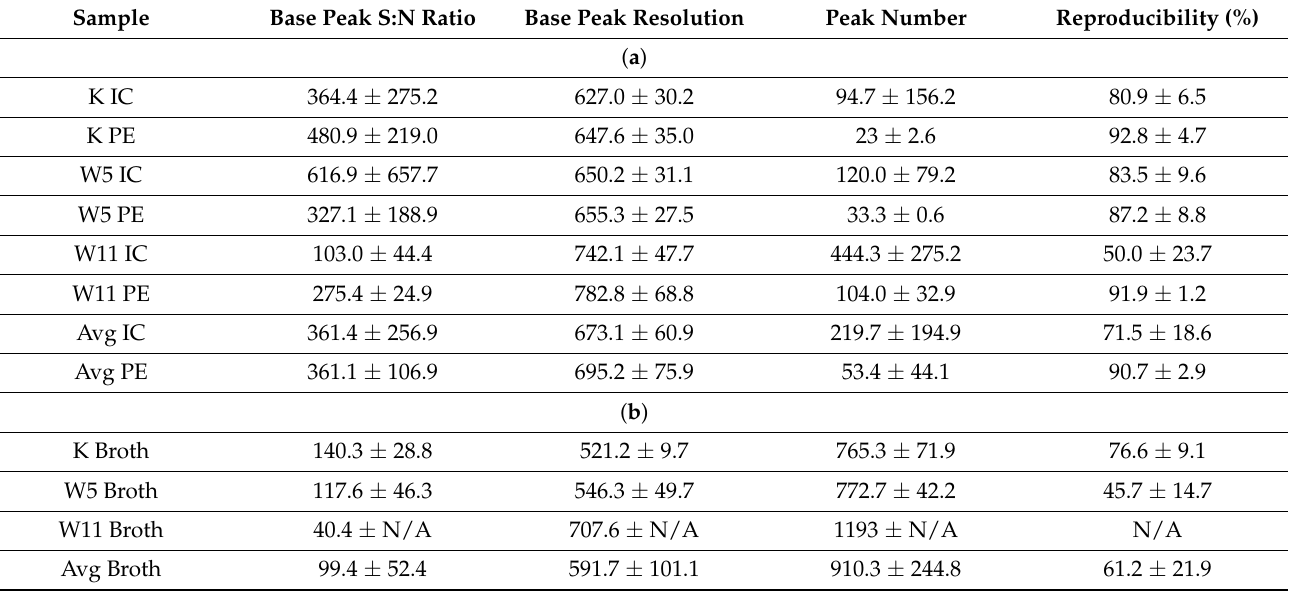
a Data shown represent averages of triplicate samples from a single preparation followed by their standard deviations. Results for all parameters show a significant difference between IC and PE with the exception of W5 base peak resolution and reproducibility. b Data shown represent averages of triplicate samples from a single preparation followed by their standard deviations. Standard deviations and reproducibility are not available